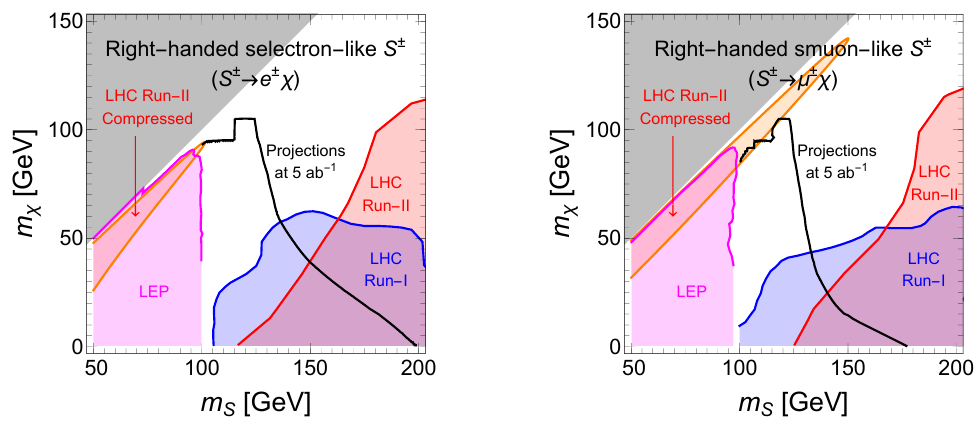
Figure 4 . The current constraints for right-handed selectron-like and right-handed smuon-like scalar S in the m - m plane. The shaded regions are exclusions from previous experiments, as DM S stated in figure 3. The black lines are projections for the CEPC reach at 5 ab − 1 . The zigzag shape of the projections at m 120 GeV are due to the inclusion of off-shell S ∼